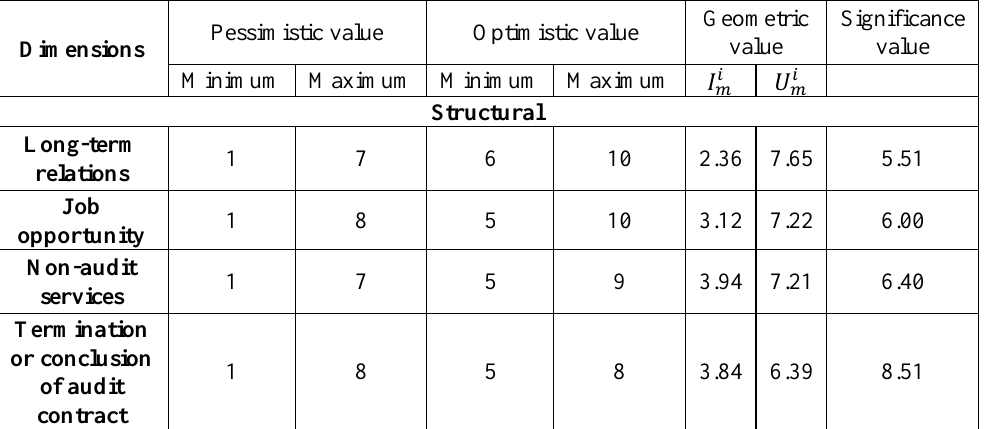
Table 1. Performance indicators based on the Fuzzy Delphi